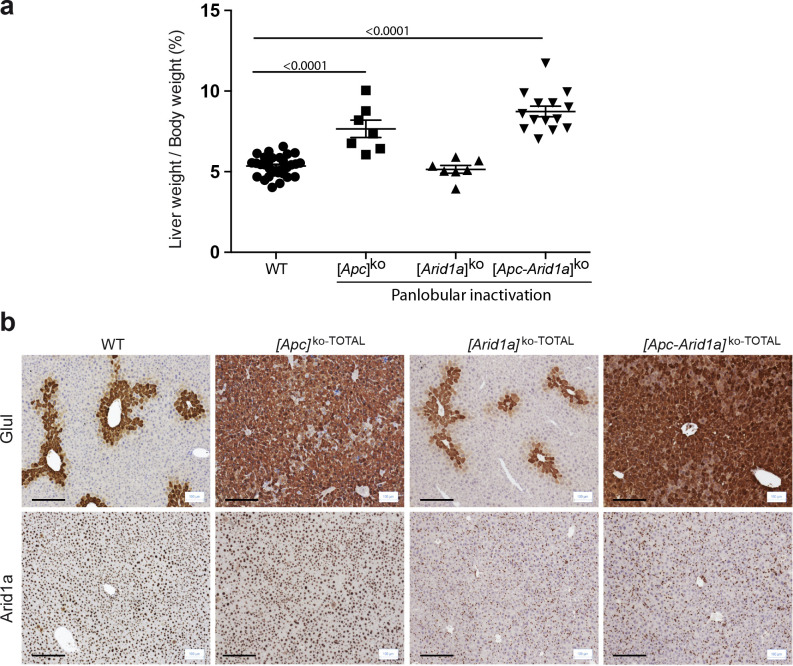
Panlobular inactivation of Apc and/or Arid1a in hepatocytes.(a) Hepatomegaly in mice after panlobular inactivations. WT (n = 30), [Apc]ko-TOTAL (n = 9), [Arid1a]ko-TOTAL (n = 9), and [Apc-Arid1a]ko-TOTAL (n = 14) mice. Data are presented as the mean + SEM and analyzed using one-way ANOVA. (b) Immunostaining of glutamine synthetase (Glul) and Arid1a after Apc and/or Arid1a loss in all hepatocytes in mouse liver. Note the physiological staining of Glul surrounding the centrilobular vein (cv) in WT and [Arid1a]ko-TOTAL livers and the remaining nonparenchymal staining of Arid1a after hepato-specific Arid1a inactivation ([Arid1a]KO-TOTAL and [Apc-Arid1a]KO-TOTAL). Apc loss leads to overactivation of the Wnt/β-catenin pathway and, consequently, increased Glul staining of hepatocytes to the whole lobule. Scale bars = 200 μm.Figure 5—figure supplement 1—source data 1.Liver to body weight ratio (Figure 5—figure supplements 1a).